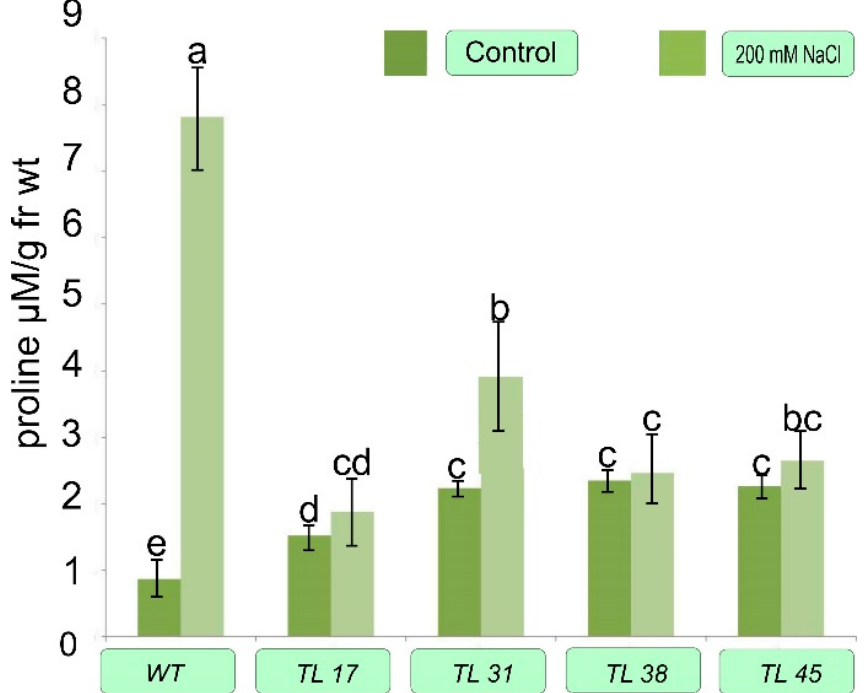
Figure 7. Total chlorophyll content in transgenic plant lines. Control—medium Tc without adding NaCl; NaCl—medium Tc with the addition of 200 mmol NaCl. Columns with the same letters are not significantly different ( p ≤ 0.05, Duncan’s test).